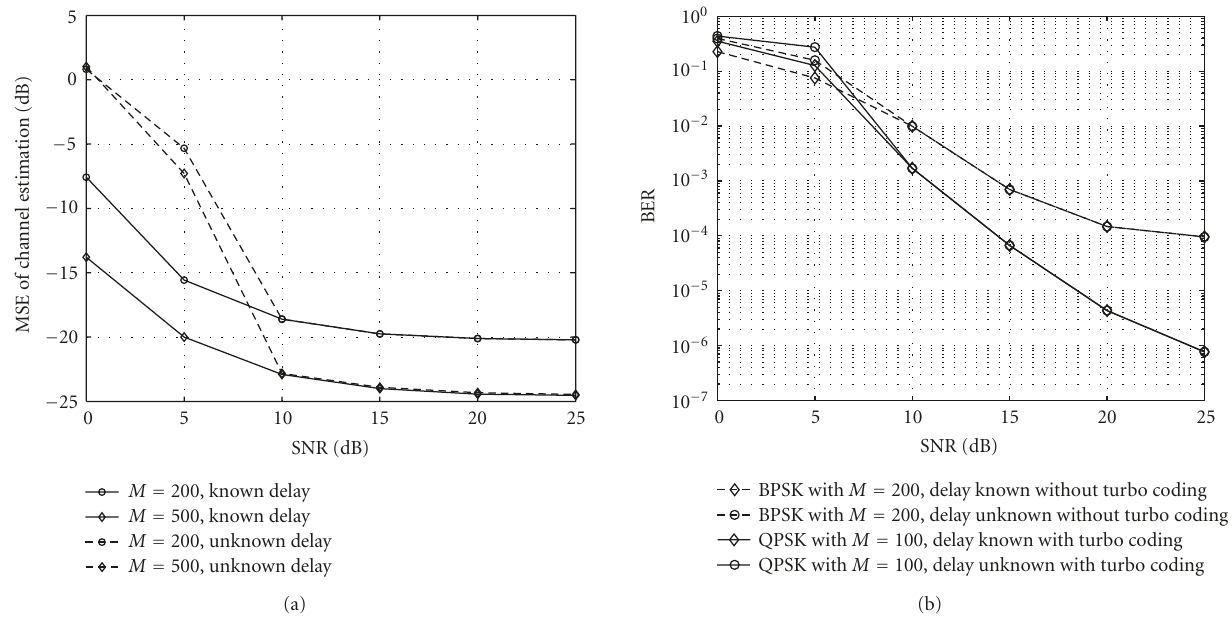
Figure 7: Example 3, asynchronous two-branch transmission with two receivers, N = 3( L +1), data rate = 1.5, with noise variance estimation, (a) normalized channel estimation MSE versus SNR, (b) BER versus SNR when M =